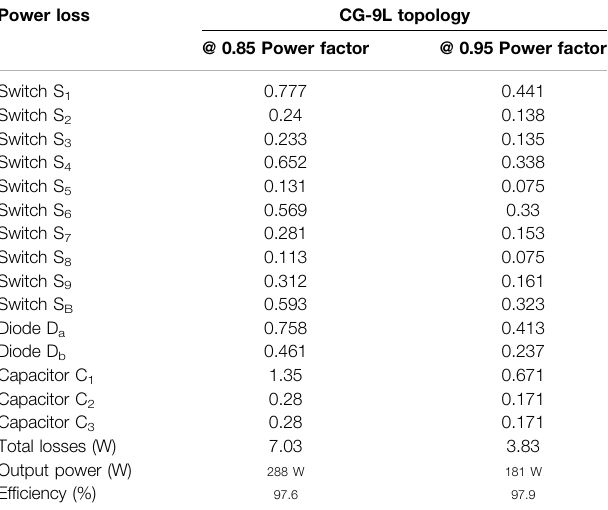
TABLE 1 | Power loss and ef fi ciency of the proposed topology. Power loss